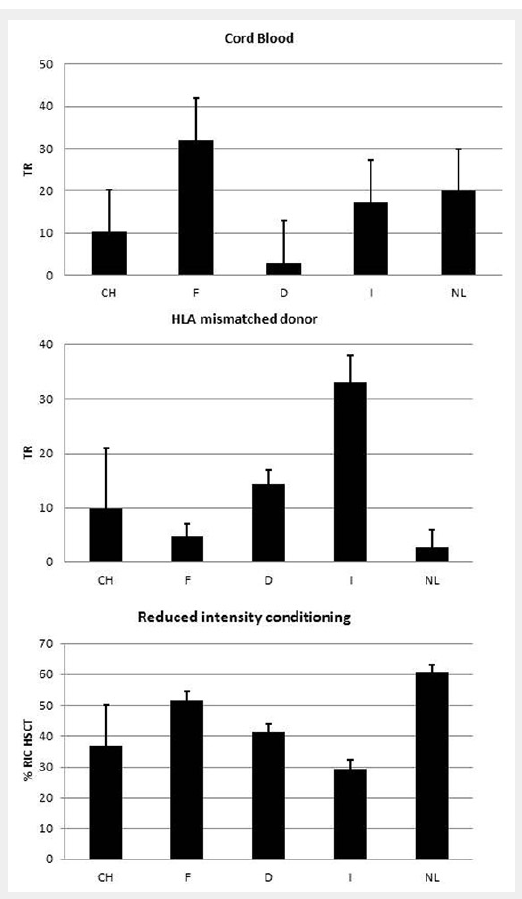
Allogeneic HSCT rates per 10 million inhabitants and year. 4a: use of cord blood transplants. 4b: use of HLA- mismatched family donors. 4c: use of reduced intensity conditioning as percentage of all allogeneic HSCT (CH: Switzerland, F: France, D: Germany, I: Italy, NL: the